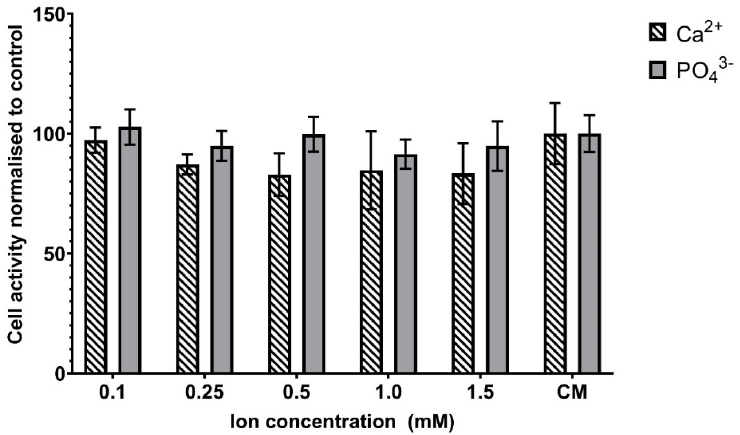
Figure5. Effect of calcium and phosphate ions on the metabolic activity of MG63 osteoblastic cells. PrestoBlue analysis following the exposure of cells to varying concentrations of calcium and phosphate ions. Bars indicate the mean percentage fluorescence values (± SD, n = 3) relative to the fluorescence of cells incubated in normal culture medium (CM) only.